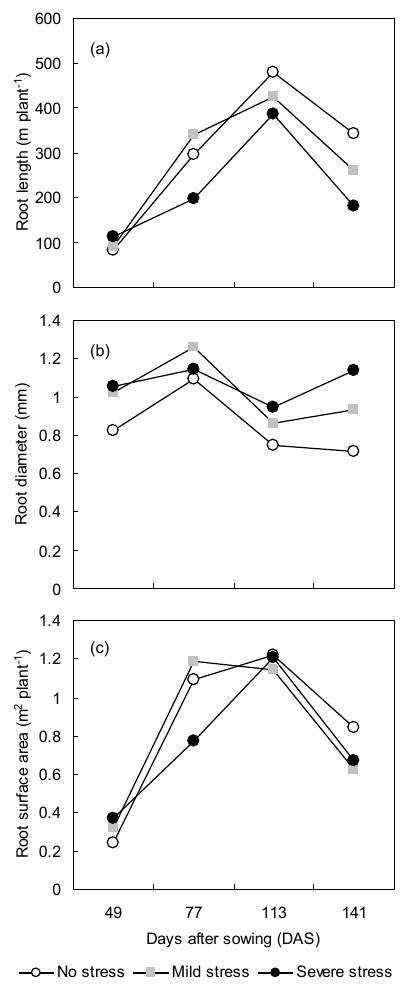
Figure 4. Total root length, average diameter and total surface area per plant affected by water stress in